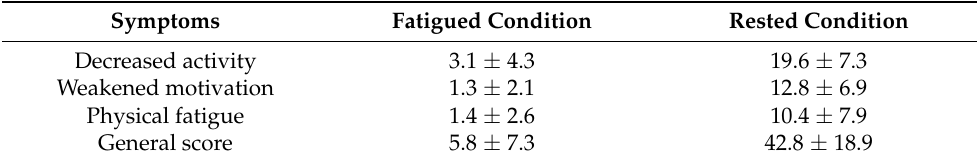
Table 1. Severity of fatigue symptoms reported in the Japanese Questionnaire (lower score = more severe reported symptoms). The general score was defined as the sum of the results from three subscales. All p < 0.001.